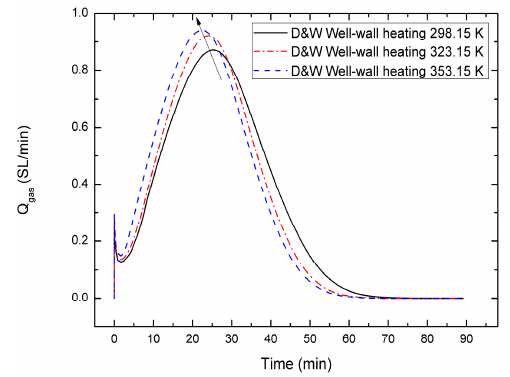
Figure 7. Gas generation rate of the depressurization combining with different well-wall heating temperature.